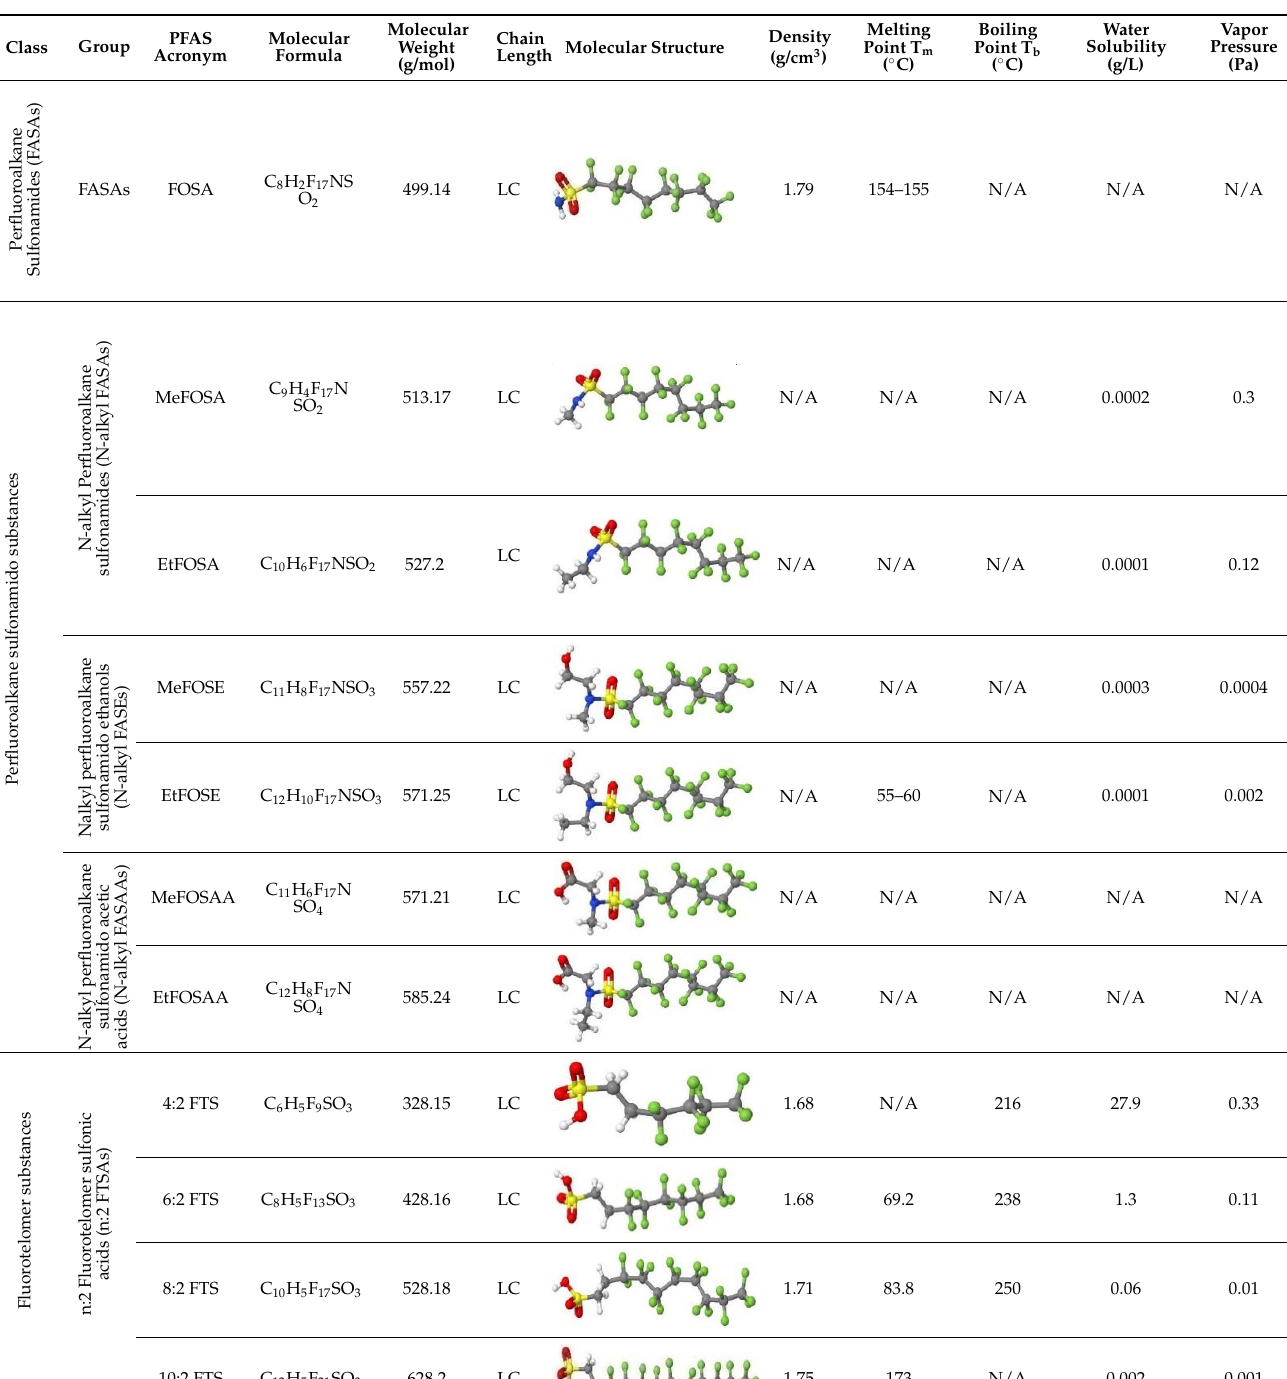
* Short Chain, ** Long Chain.